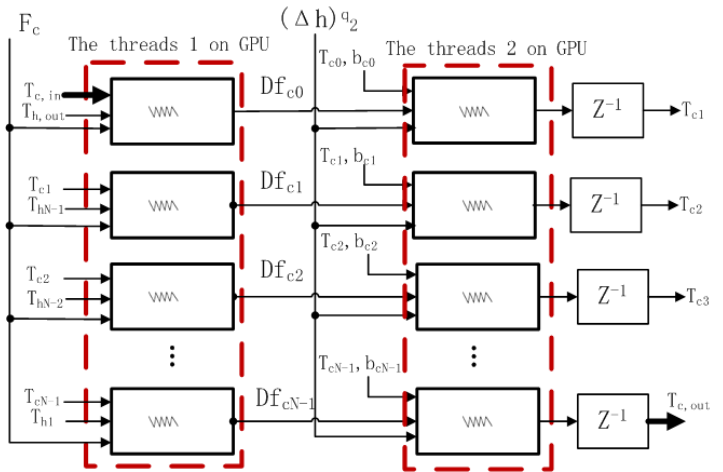
Figure 5. The thread blocks of the proposed parallel model in cold fluid for the counter-flow heat exchanger .